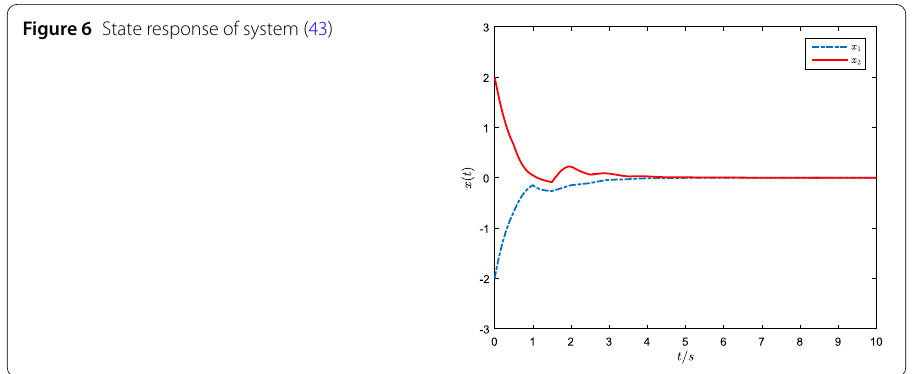
Figure 6 State response of system